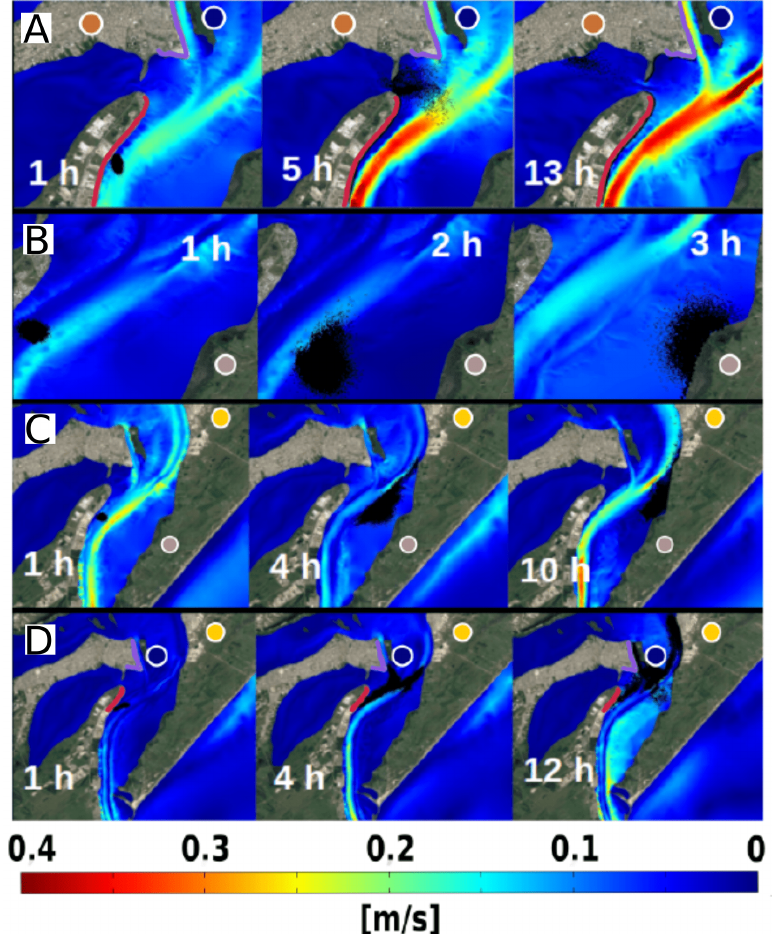
Figure 4. Simulation results of oil spill events on flood conductions ( A – D ). The oil (black dots) is advected seaward in all events. The color scale shows the current magnitude (ms − 1 ), higher in the channel of the